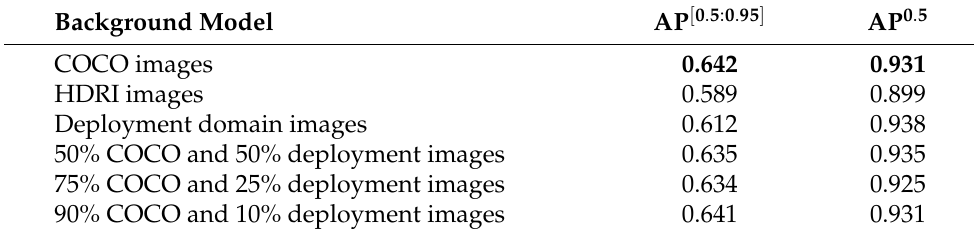
Table 4. Background results.